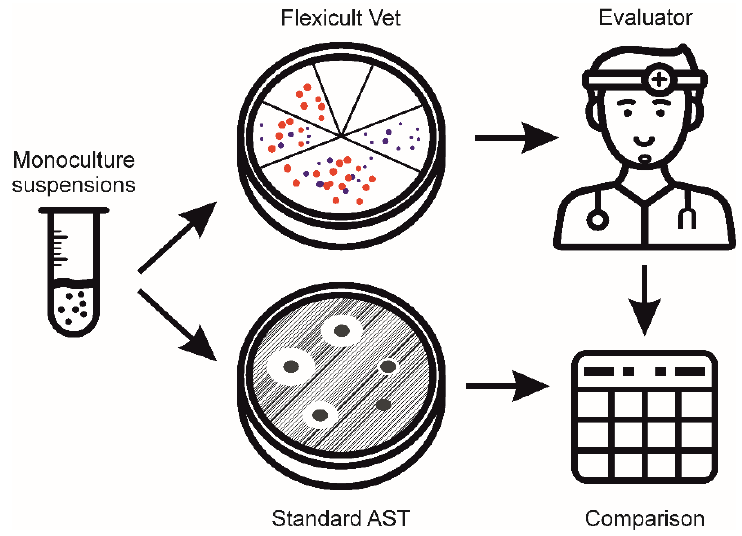
Figure 5. Veterinary microbiological experts and veterinary clinicians (Evaluators) performed an identification and antimicrobial susceptibility testing (AST) of UTI bacteria growing on Flexicult Vet plates. The results were compared to the standard AST.